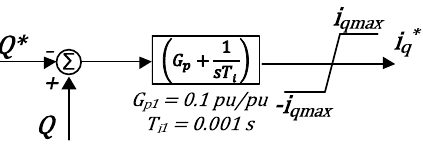
Figure 6. Reactive power control loop used in FBMMC1 and FBMMC2.